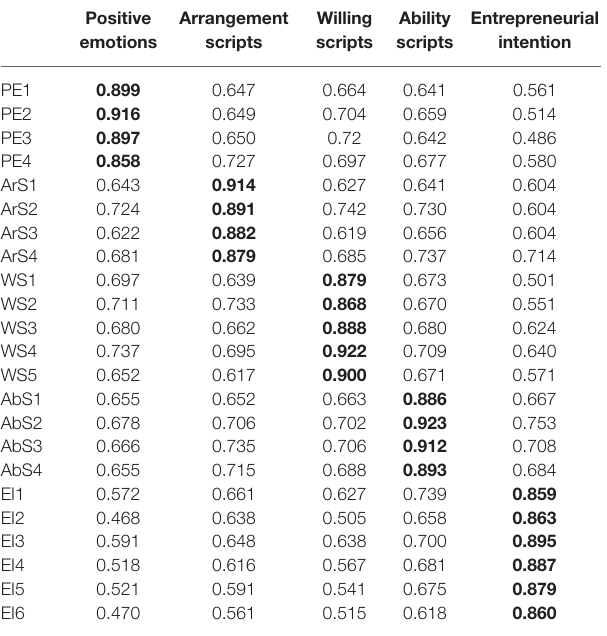
TABLE 5 | Factorloading and